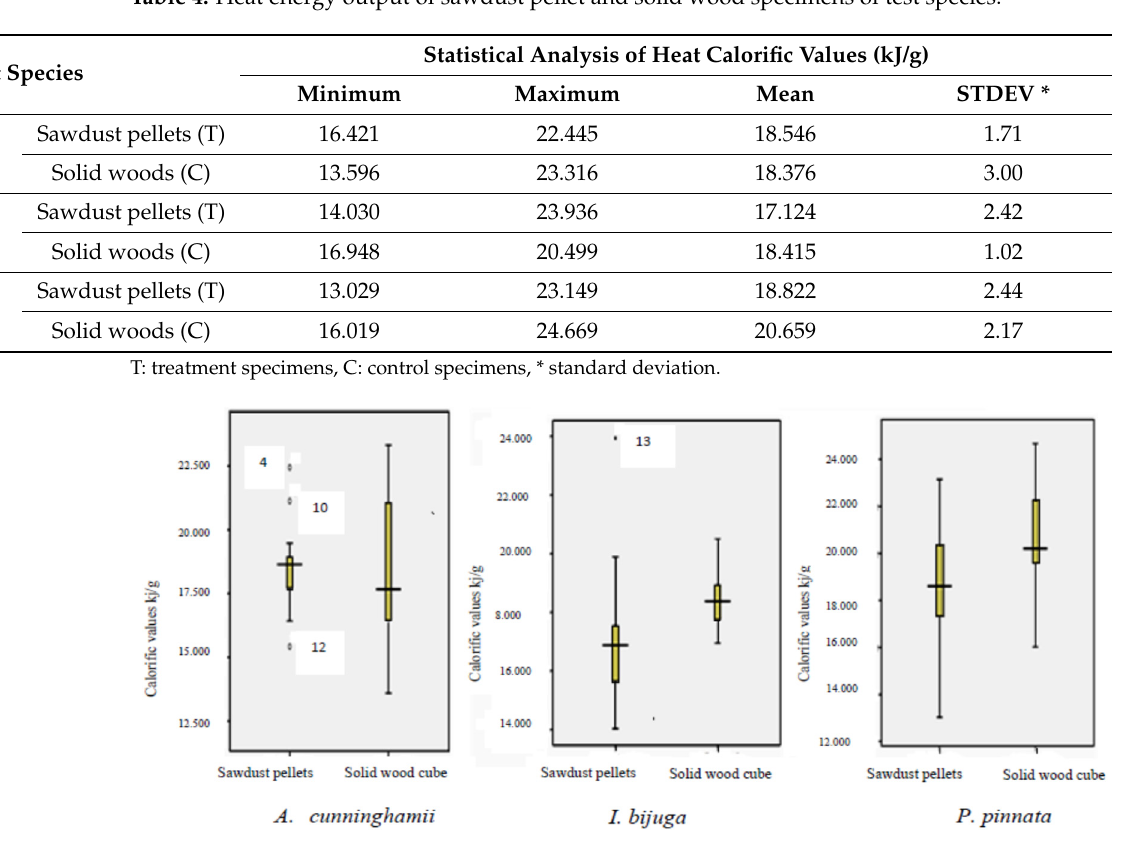
Table 4. Heat energy output of sawdust pellet and solid wood specimens of test species.